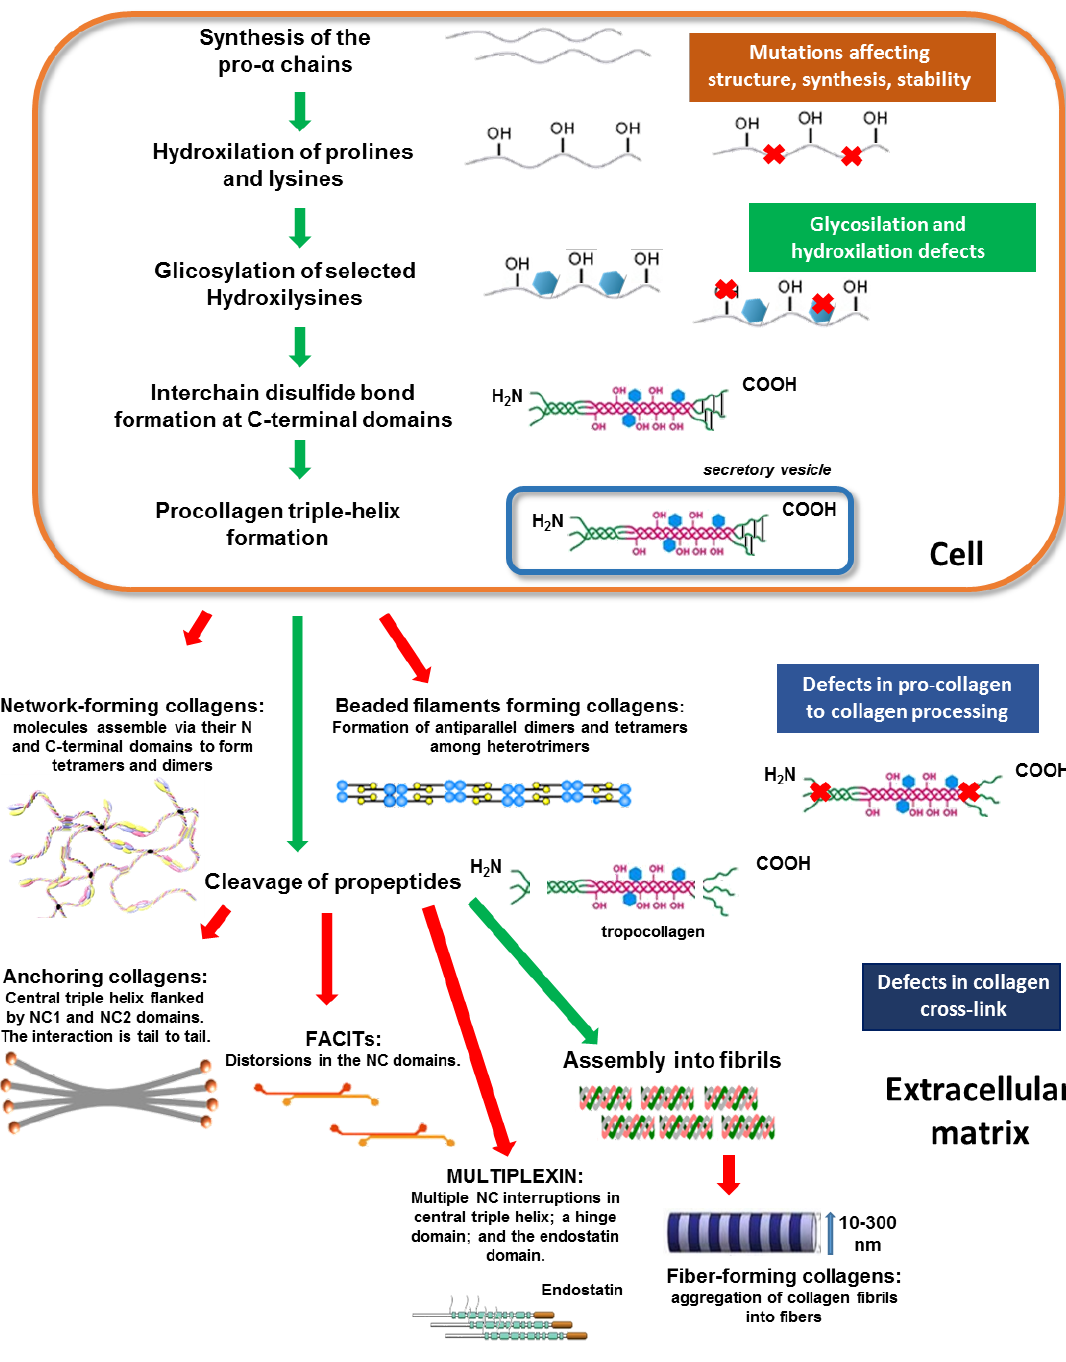
Figure 2. Schematic representation of collagen biosynthesis steps. The main biosynthesis steps of various collagen types are indicated. Green arrows highlight the contiguous processing steps whereas red arrows indicate the final step of collagen assembly into the different structural conformations. Coloured boxes on the right indicate potential alterations occurring during collagen processing at different steps, thus causing abnormalities in the structure and/or assembly. Abbreviations: NC, non-collagenous domain.